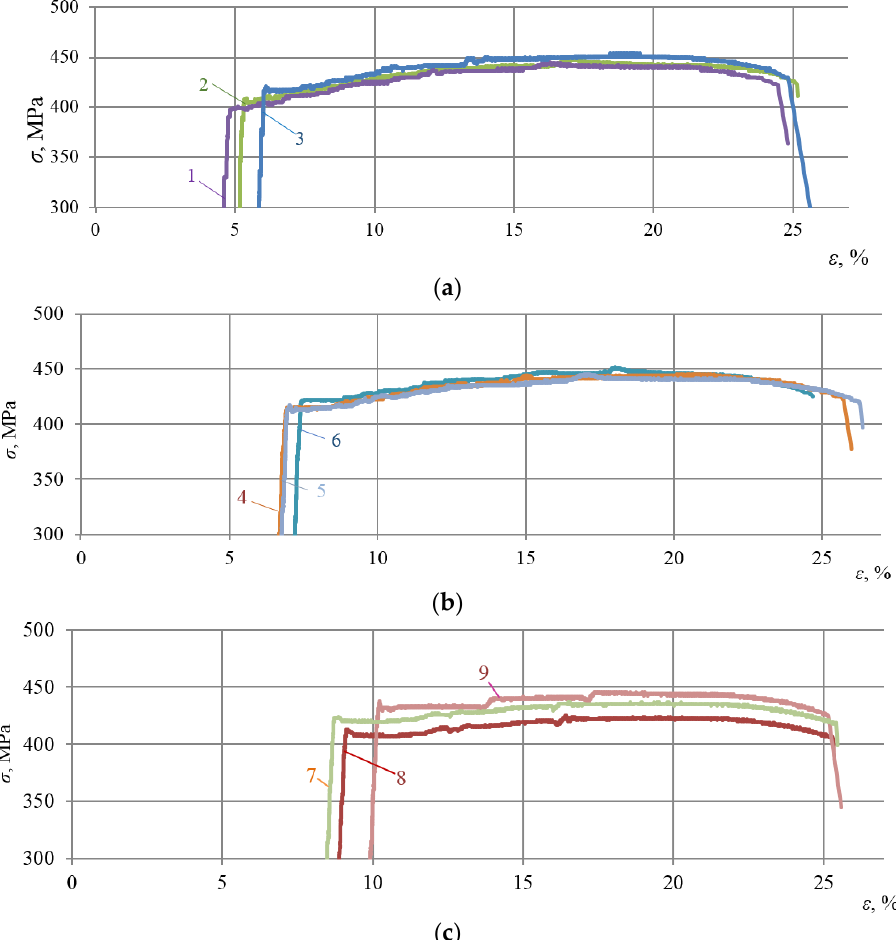
Figure 3. Deformation diagrams of the D16ChATW alloy during static stretching after DNP of different intensities: ( a ) — 1 —ε imp = 4.26%; 2 —ε imp = 4.71%; 3 —ε imp = 5.40%; ( b ) — 4 —ε imp = 6.21%; 5 —ε imp = 6.27%; 6 —ε imp = 6.69%; ( c ) — 7 —ε imp = 8.0%; 8 —ε imp = 8.39%; 9 —ε imp = 9.38%.